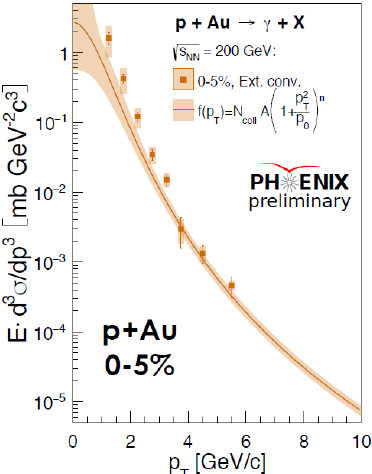
Figure 1. Invariant differential yield of direct photons in 0-5% most central p+Au collisions at  s NN = 200 GeV. The smooth curve and the shaded region correspond to the binary-scaled p+p